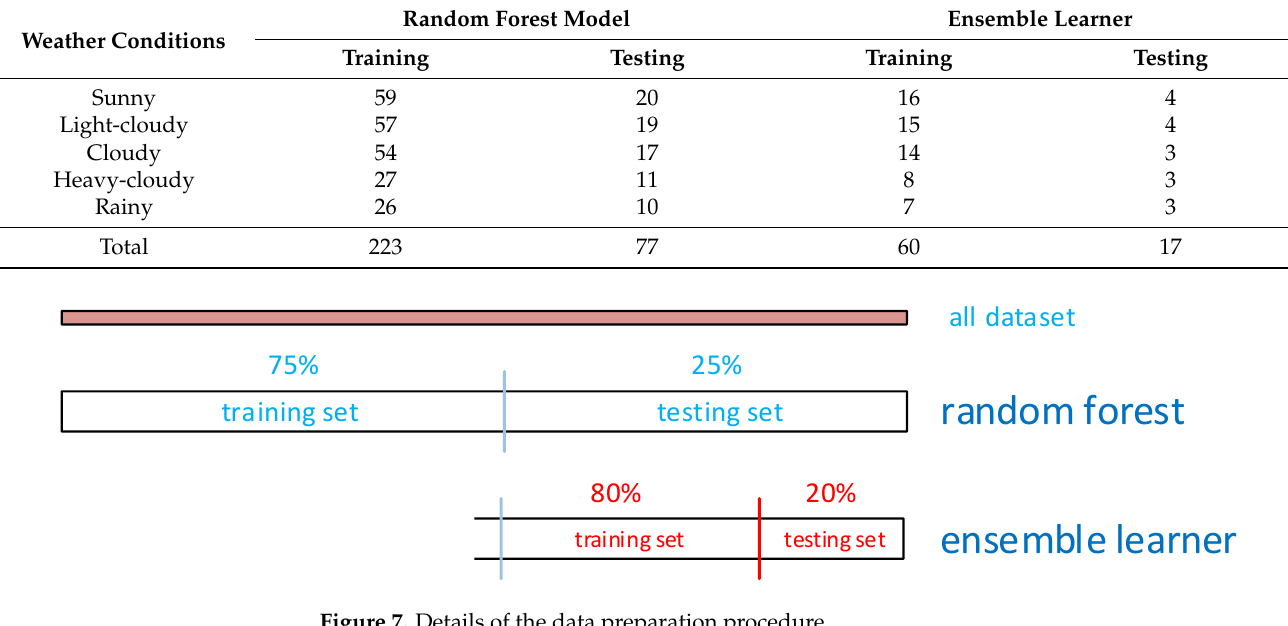
Table 3. The number of days that are used for training and testing.